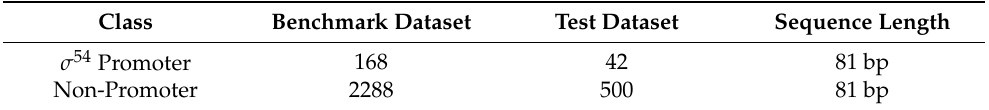
Table 1. Parameters of benchmark and test